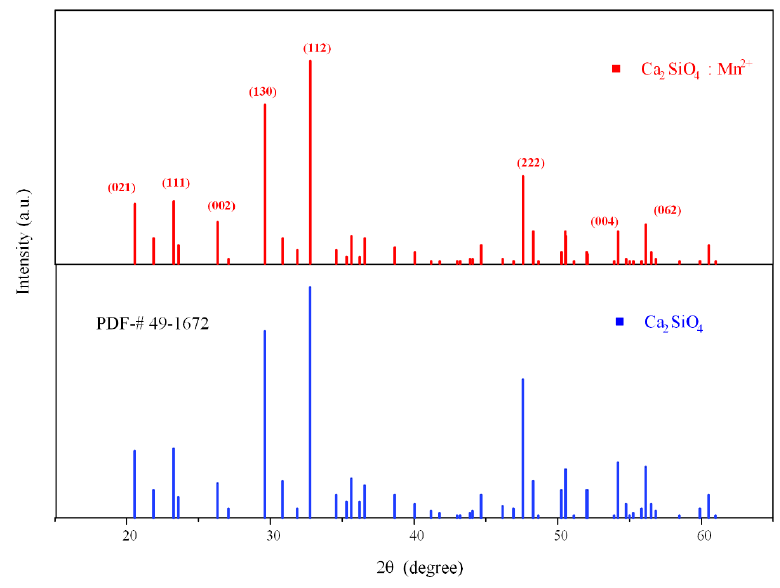
Figure 1. The XRD pattern of Ca 2 SiO 4 (CSO):Mn 2+ and the standard PDF of CSO. As shown in Figure 2 , it is worth noting that the main peak of CSO:Mn 2+ distributed at 29.7° is slightly shifted back relative to the standard peak position, and the shift of the diffraction peak implies that the crystal lattice of the doped sample has been shrunk. Ac- cording to the Bragg equation, 2dsin θ = nλ, where d is the interplanar spacing, n is the reflection order, and λ is the incident wavelength. Since the radius of the manganese ion (0.66Å ) is smaller than the radius of the calcium ion (0.1Å ), when Mn 2+ replaces Ca 2+ sites in the dicalcium silicate lattice, the lattice shrinks and the interplanar spacing d decreases, so the diffraction angle θ increases. The unit cell parameters of pure and Mn 2+ -doped CSO samples were calculated, and the results are given in Table 1.